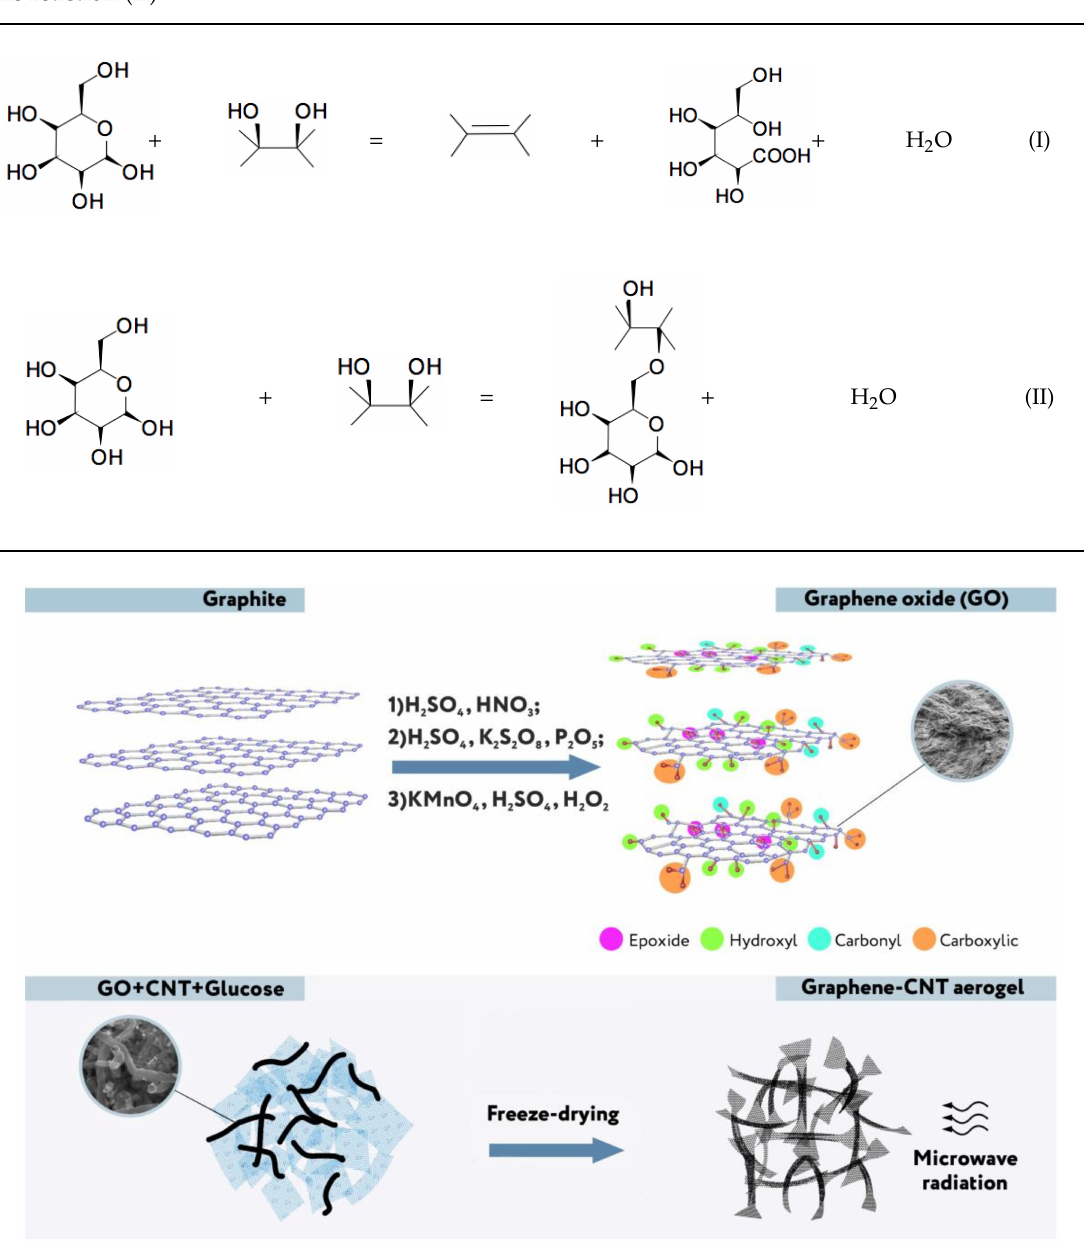
Figure 2. Scheme of some stages of aerogel